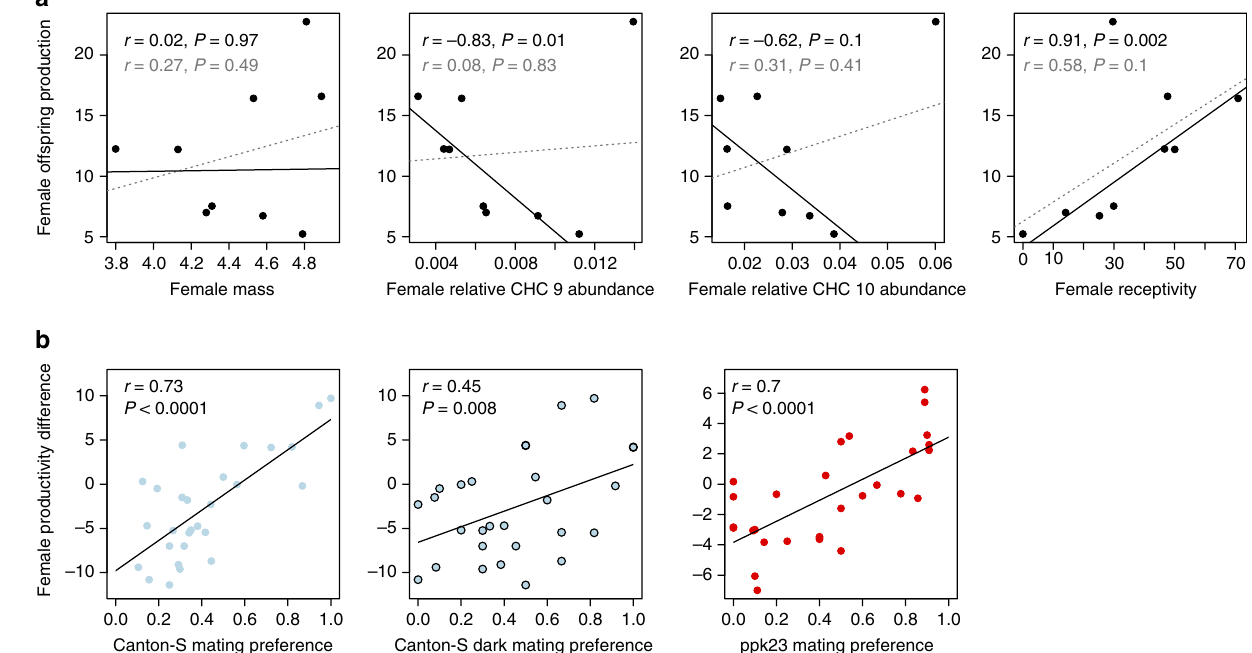
Figure 4 | Male mating preferences coincide with female offspring production. ( a ) Relationships between female offspring production and mass, relative abundance of CHC 9, relative abundance of CHC 10 and female receptivity. Black lines and text show correlations between female traits with data from an outlier isogenic line removed, whereas grey lines and text show correlations with all data. Reported correlation coefficients and P -values are from Pearson’s correlation. ( b ) Correlations between the proportions of the first female line mated and pairwise differences in female offspring production when an outlier line was removed. Significance was tested via permutation tests to avoid pseudoreplication. Regression lines for all plots represent geometric mean